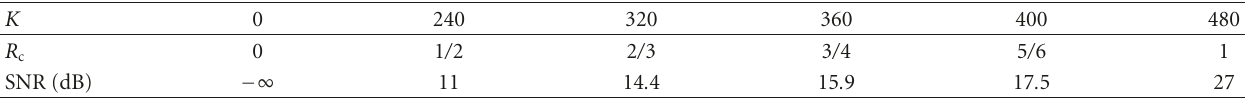
Table 1: In the table the information packet length K and the coding rate R c are indicated for each SNR threshold. Note that for each threshold we have: K/R c = 480, that is, all encoded packets have the same length.